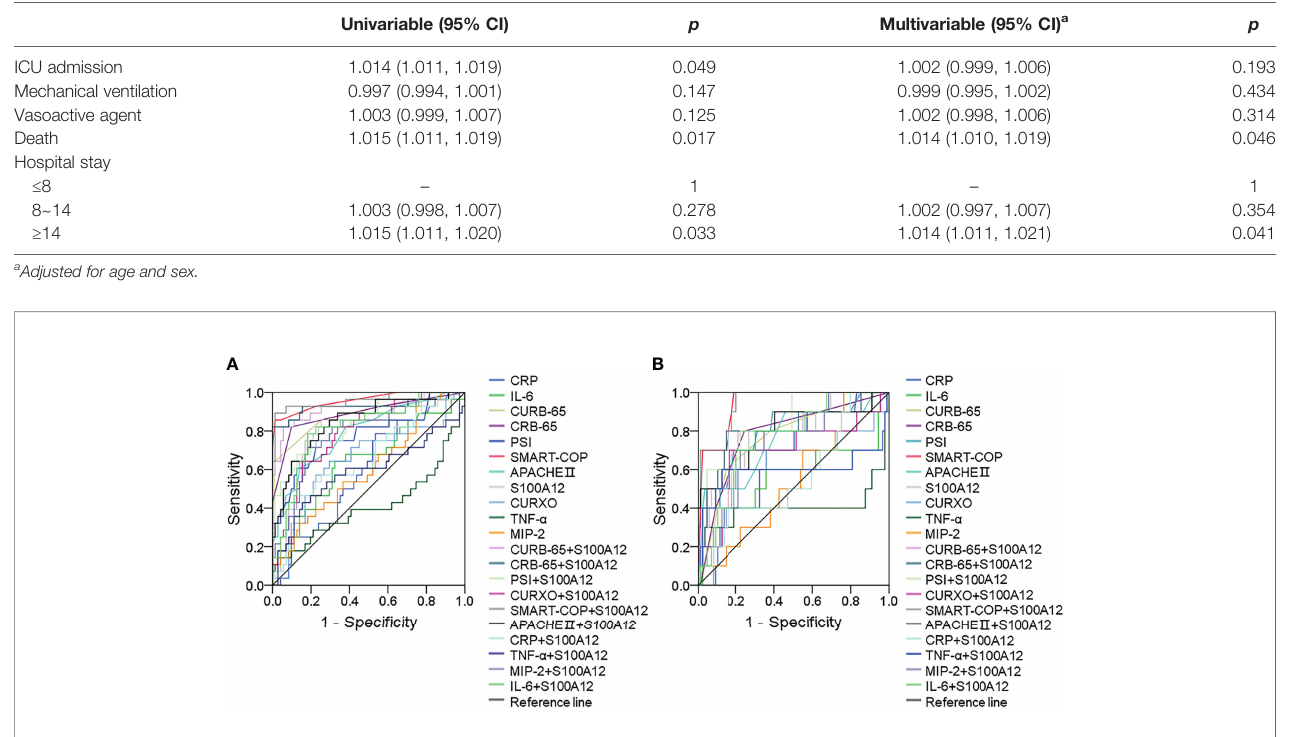
FIGURE 3 | Receiver operating characteristic curves for different predictive biomarkers on admission. (A) ROC curve was used to evaluate the predictive values for severity of different biomarkers among CAP patients. (B) ROC curve was used to evaluate the predictive values for death of different biomarkers among CAP patients.